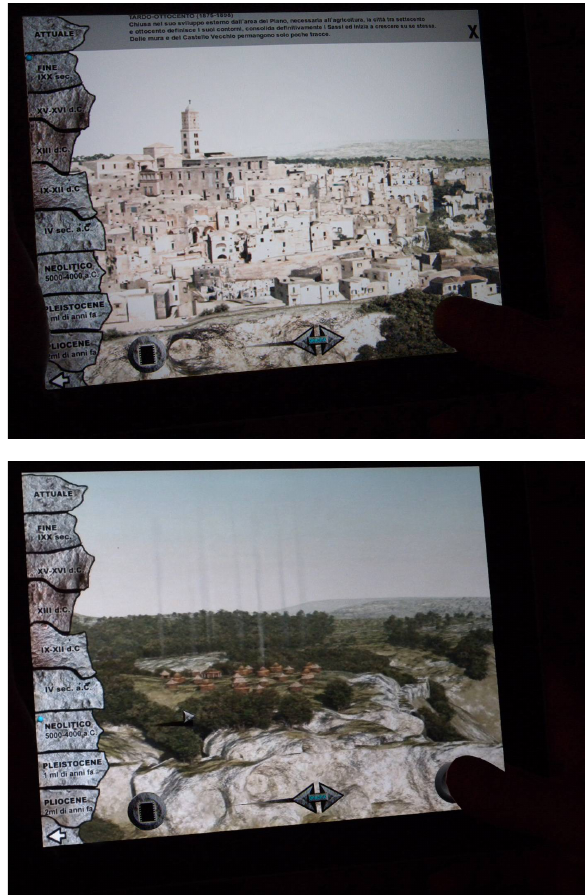
Figure 3a – 3b: . Interactive panorama, view of Matera from the “Belvedere della Murgia”: the first image refers to the end of the IXX century, the second one to the Neolithic age (5000- 4000 B.C.).